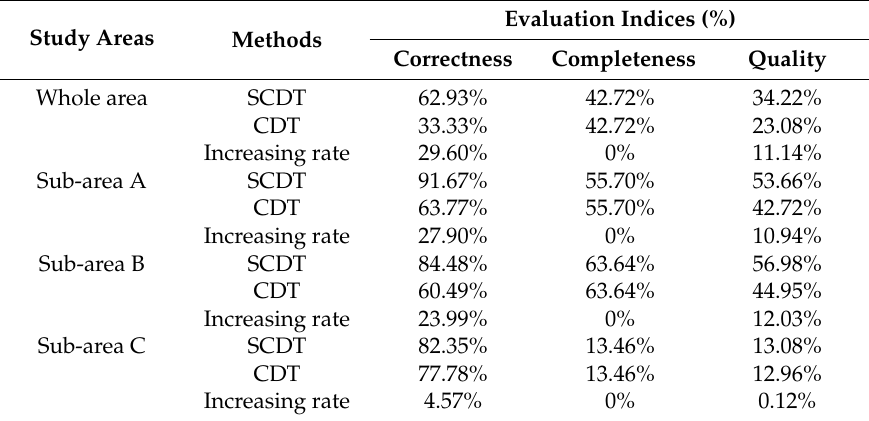
Table 1. Increasing rate of the proposed